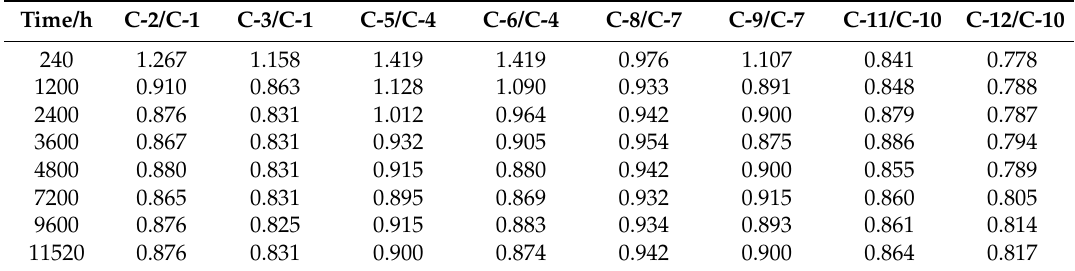
Table 9. Different effects of expansion agent concentration on the creep of concrete.